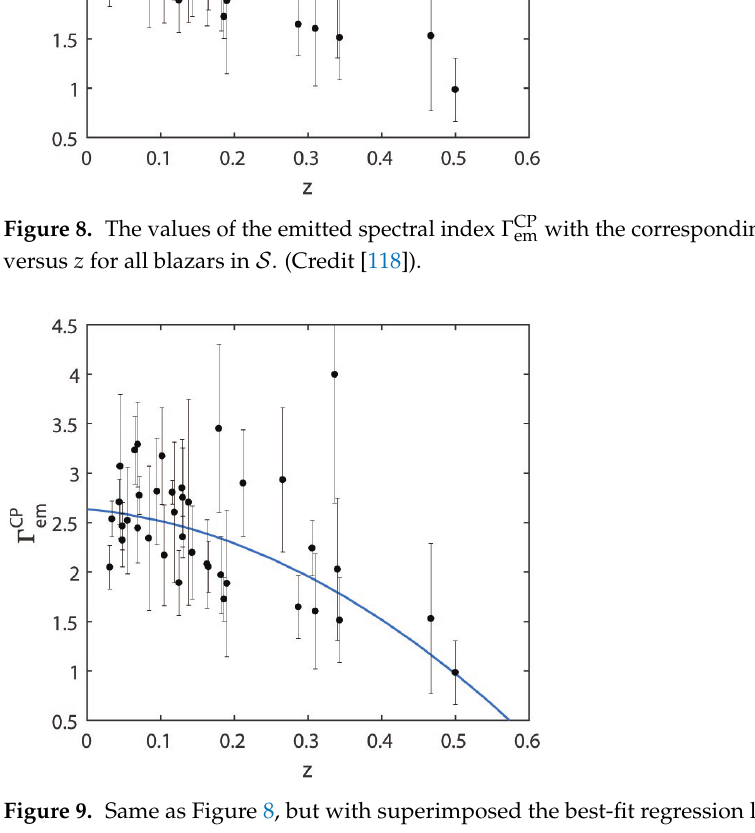
Figure 9. Same as Figure 8, but with superimposed the best-fit regression line with χ 2 (Credit